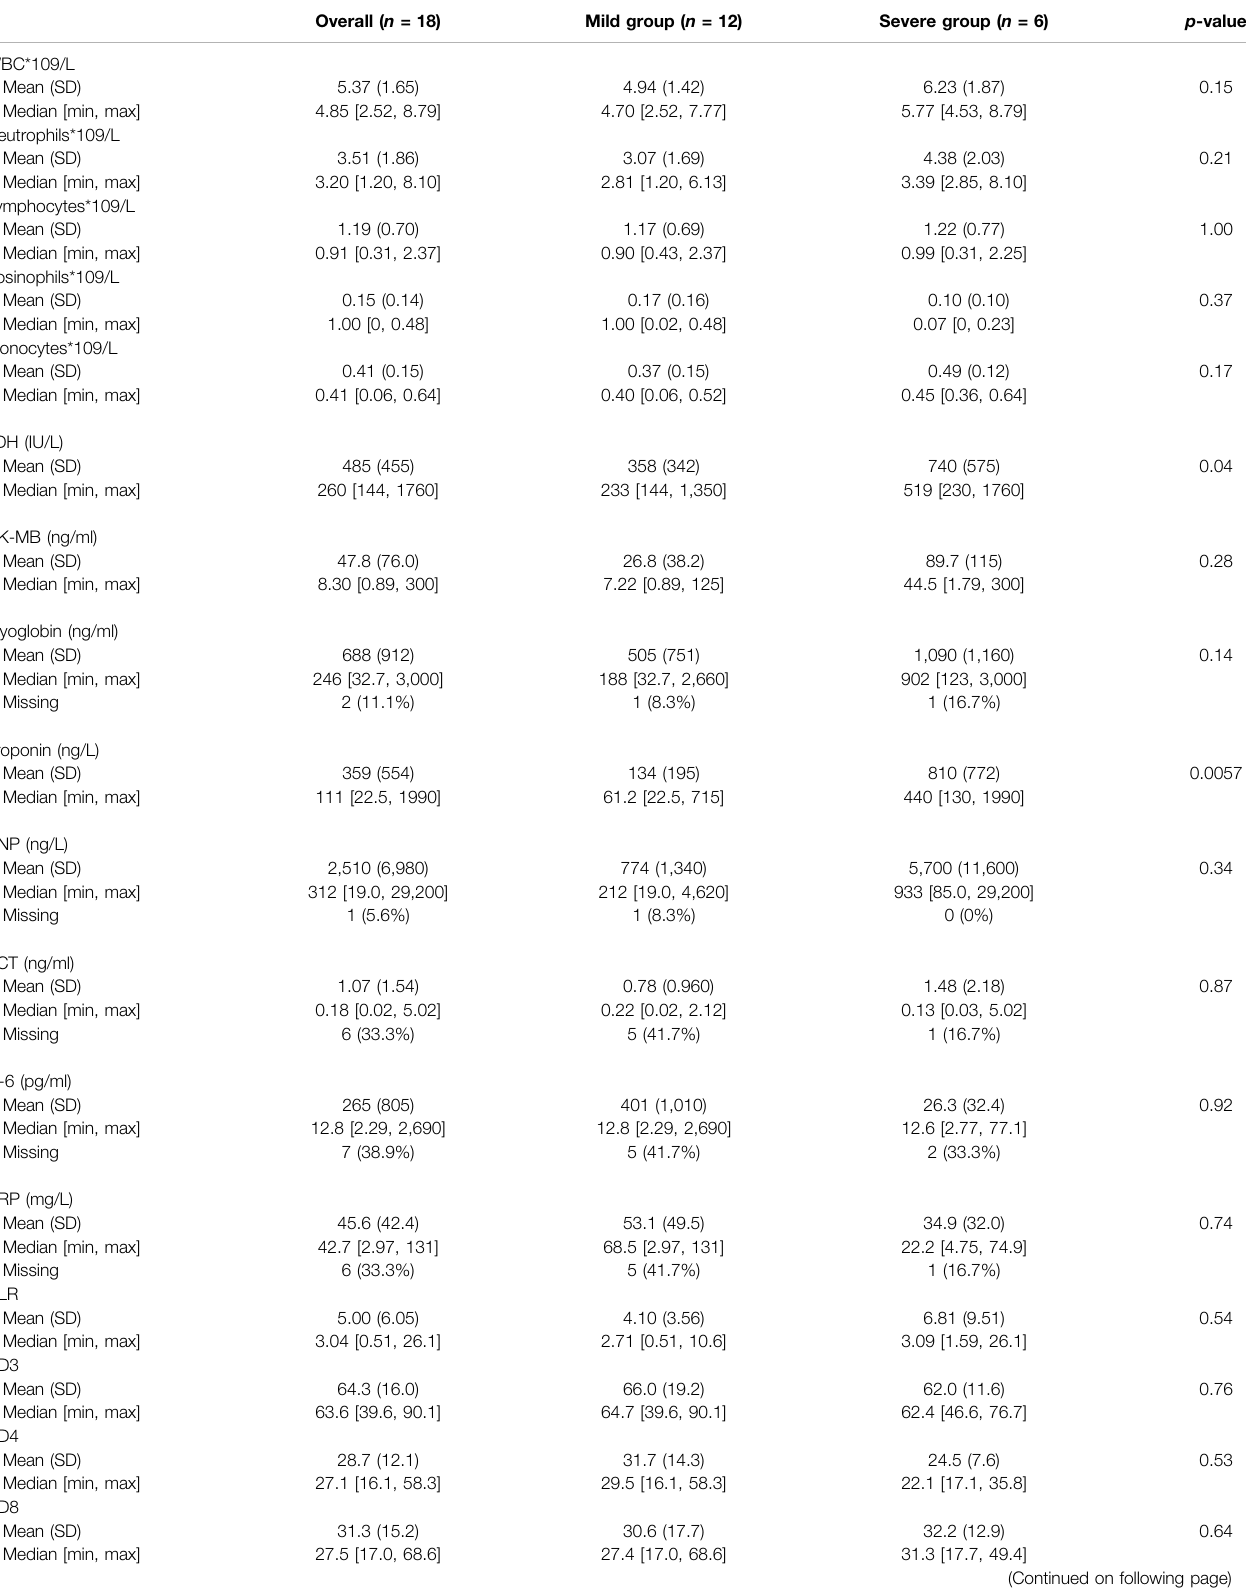
TABLE 3 | Laboratory result, cardiac markers, and ECG in all